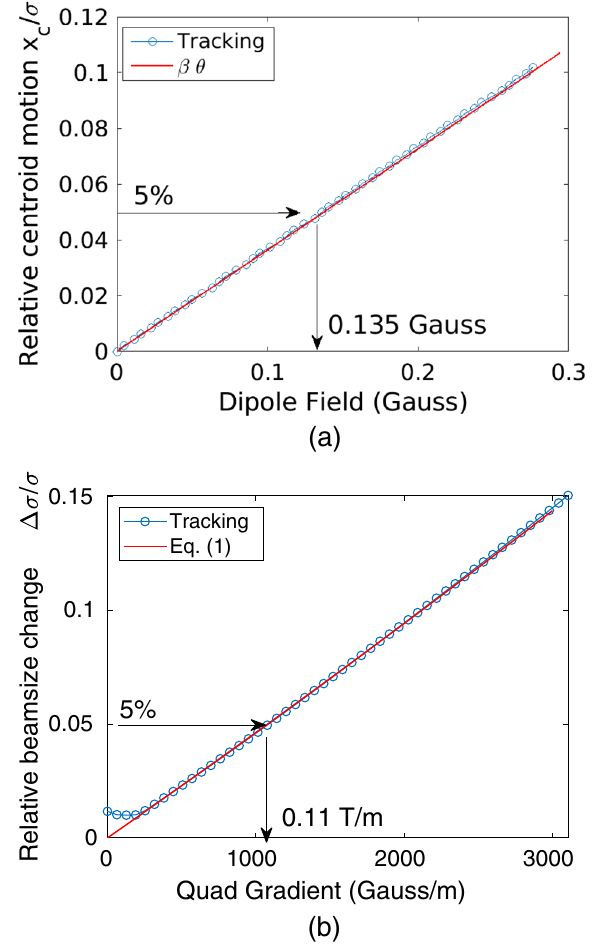
FIG. 5. Perturbations on the stored beam for different dipole (a) quadrupole (b) field strengths at the fieldfree region of NLK.